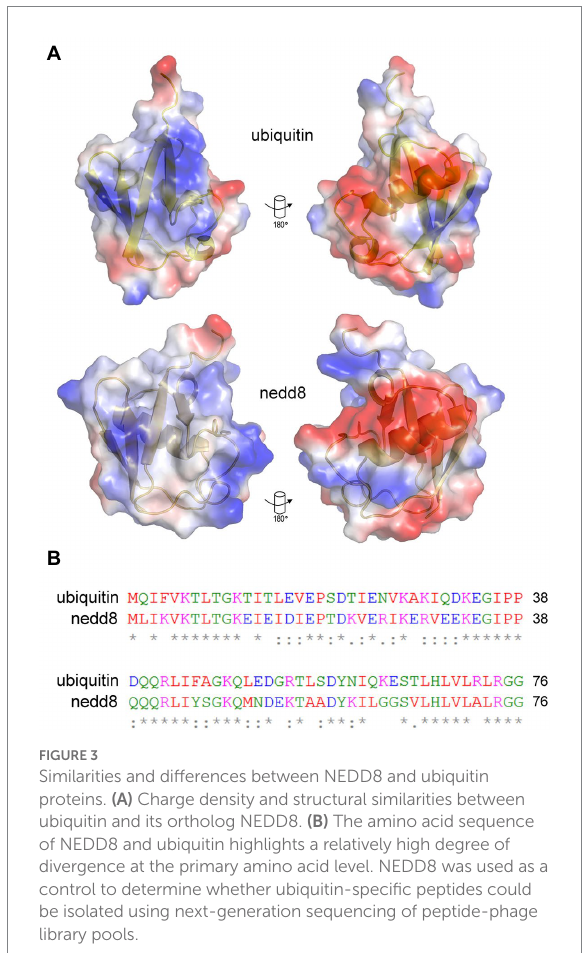
FIGURE 3 Similarities and differences between NEDD8 and ubiquitin proteins. (A) Charge density and structural similarities between ubiquitin and its ortholog NEDD8. (B) The amino acid sequence of NEDD8 and ubiquitin highlights a relatively high degree of divergence at the primary amino acid level. NEDD8 was used as a control to determine whether ubiquitin-specific peptides could be isolated using next-generation sequencing of peptide-phage library